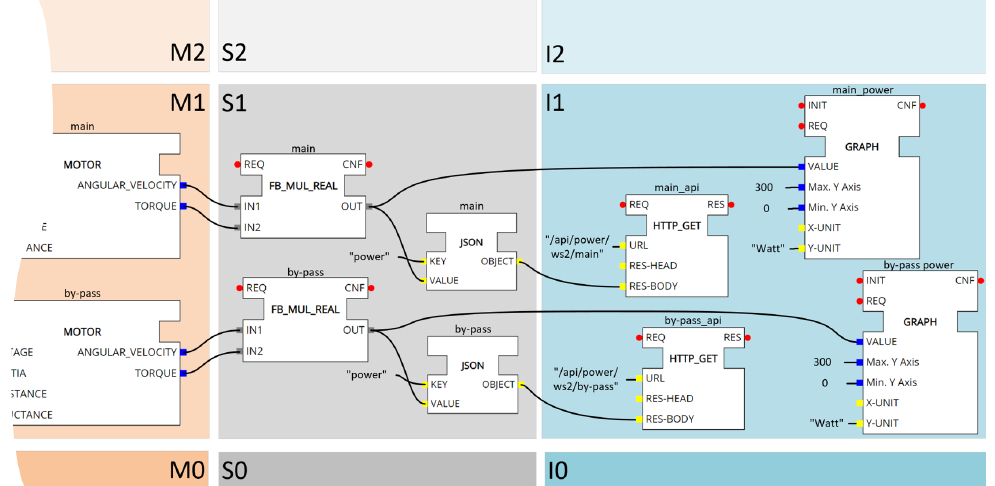
Figure 17. The signal and interface layers for the transportation digital resource in the FASTory use case. [Source: Own